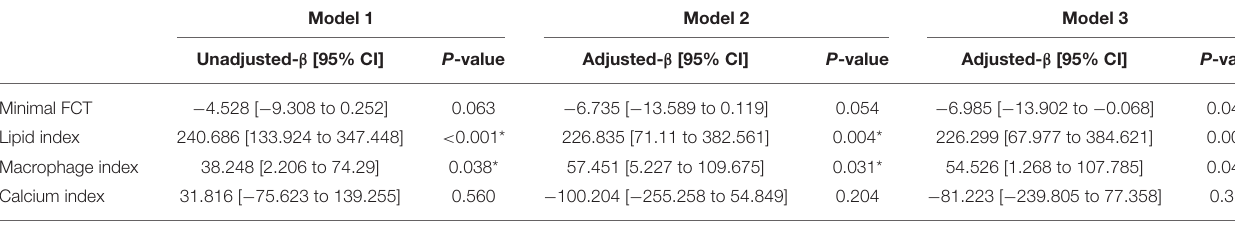
TABLE 3 | Linear regression analyses of pre-procedure HbA1c levels on vulnerability